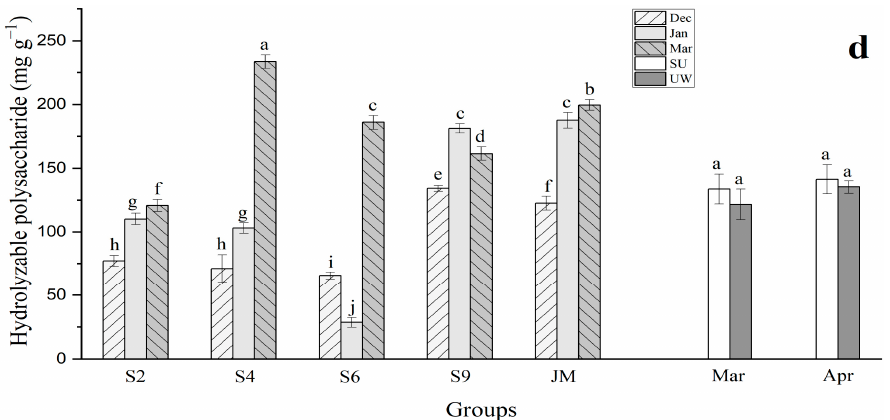
Figure 2. Proximate compositions of different N. yezoensis samples. ( a ), Soluble protein content; ( b ), Total protein calculated from the total nitrogen (TN) content; ( c ), Soluble sugar; ( d ), hydrolyzable polysaccharides. S2, S4, S6, and S9 are the different sites in Haizhou Bay. JM is located at Jimo aqua- farm in Qingdao. SU, samples cultivated on the water surface during the comparative experiment. UW, samples cultivated at one meter underwater during the comparative experiment. Data are mean ± SD ( n = 3). Different letters indicate a significant difference ( p < 0.05).